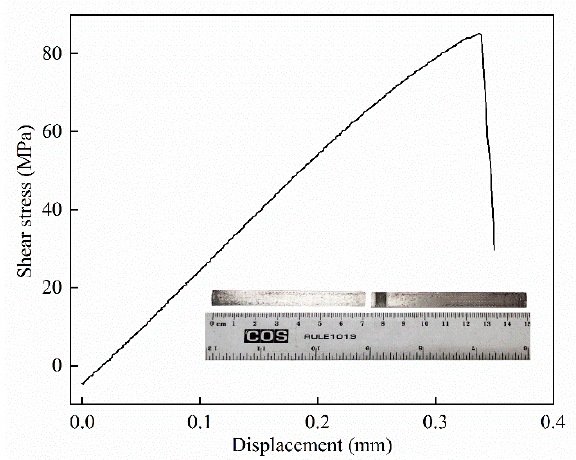
Figure 8. Typical stress-distance curves obtained by tensile-shear tests.